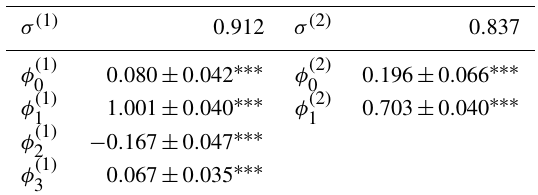
Table 1. Parameter estimates for the SETAR model for the daily winter NAO index. Here, and throughout the article, ∗∗∗ denotes parameters that are significant, with p value < 0 . 001; ∗∗ de- note parameters that are significant, with p value in the interval [ 0 . 001 , 0 . 01); and ∗ denote parameters that are significant with p value in the interval [ 0 . 01 , 0 . 05).